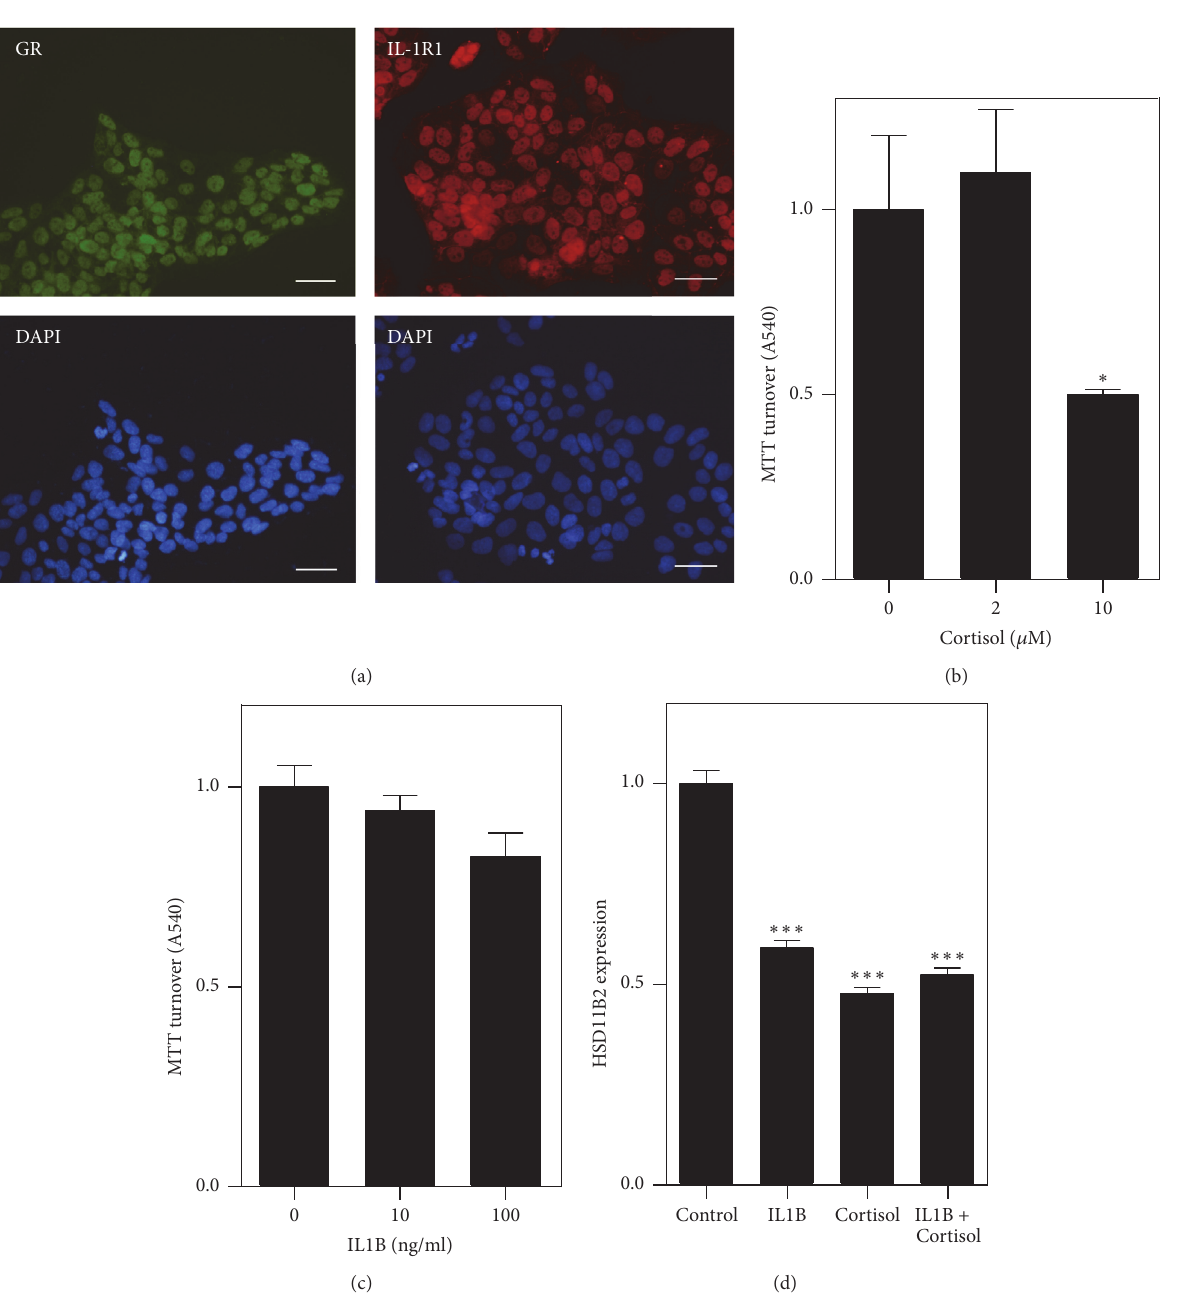
Figure 4: Cortisol and IL-1 𝛽 response in JEG-3 cells. (a) Representative photomicrographs of JEG-3 cells immunocytochemically stained for the glucocorticoid receptor (GR; green) and (c) the interleukin 1 receptor, type I (IL-1R1; red). The second panel shows the corresponding DAPI stained image. (b, c) MTT assay examining the viability of JEG3 cells treated with either 0–10 𝜇 M cortisol (b) or 0–100 ng/ml IL-1 𝛽 (c) for 24 h in vitro. (d) Graphical representation showing the levels 11 𝛽 -HSD2 in JEG-3 cells exposed to a vehicle (control), 10ng/ml IL-1 𝛽 or 2 𝜇 M cortisol for 24 h. Data are expressed as mean ± SEM ( ∗ 𝑝 < 0.05 compared to 0 𝜇 M, ∗∗∗ 𝑝 < 0.001 compared to control;